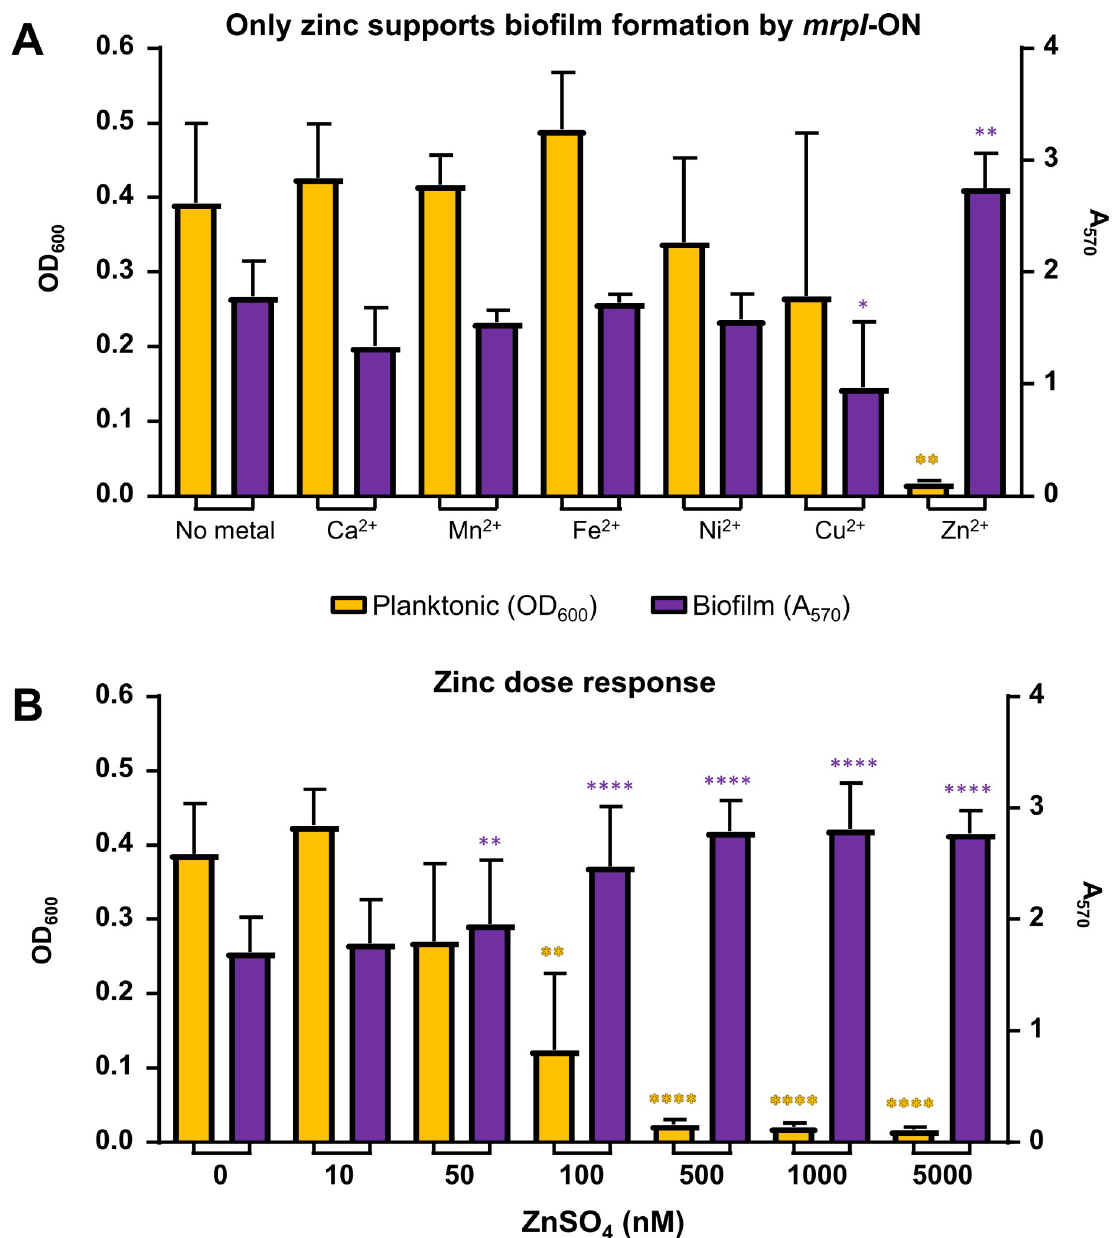
Fig 9. MrpH zinc binding is essential to its function. (A) When P . mirabilis mrpI -ON was cultured in chelexed medium ± 5 μ M metal supplementation, only zinc restored biofilm formation. Significance against “No metal” columns (OD 600 in orange and A 570 in purple) calculated by one-way ANOVA with Dunnett’s multiple comparisons test; � P < 0.05; �� P < 0.01; n = 3. (B) Biofilm formation is induced by physiologically-relevant levels of zinc. P . mirabilis mrpI -ON was cultured in chelexed Minimal A + CAA with increasing amounts of ZnSO 4 for 22 h. Planktonic growth (OD 600 ) was recorded, then biofilm was stained and quantified (A 570 ). The zinc concentration that induces biofilm formation appears to be 50–100 nM. Significance against 0 nM ZnSO 4 columns (OD 600 in orange and A 570 in purple) calculated by one-way ANOVA with Dunnett’s multiple comparisons test; �� P < 0.01; ���� P < 0.0001; n =